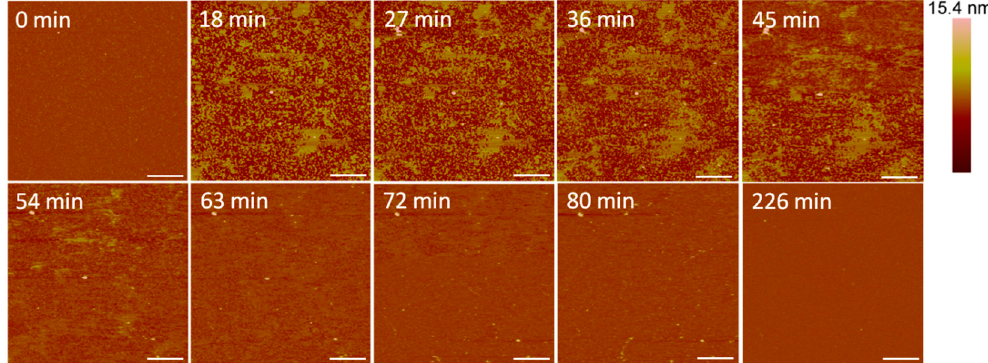
Figure 10 . Defects formed in a mica-supported PC bilayer after exposure to 10 µM indolicidin. The scale bars represent a distance of 1 µm.